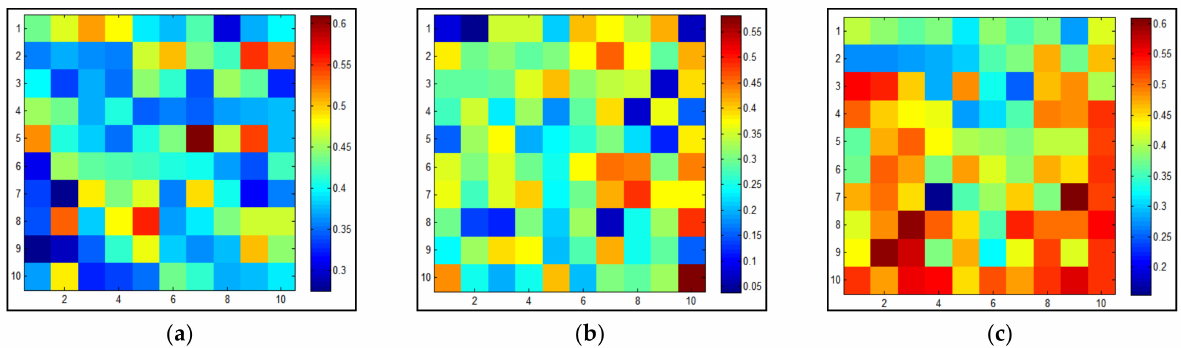
Figure 14. 10 × 10 grid multi-scale pore structure image search diagram. ( a ) Macro mesoscopic search; ( b ) Mesoscopic micro search; ( c ) Macro micro